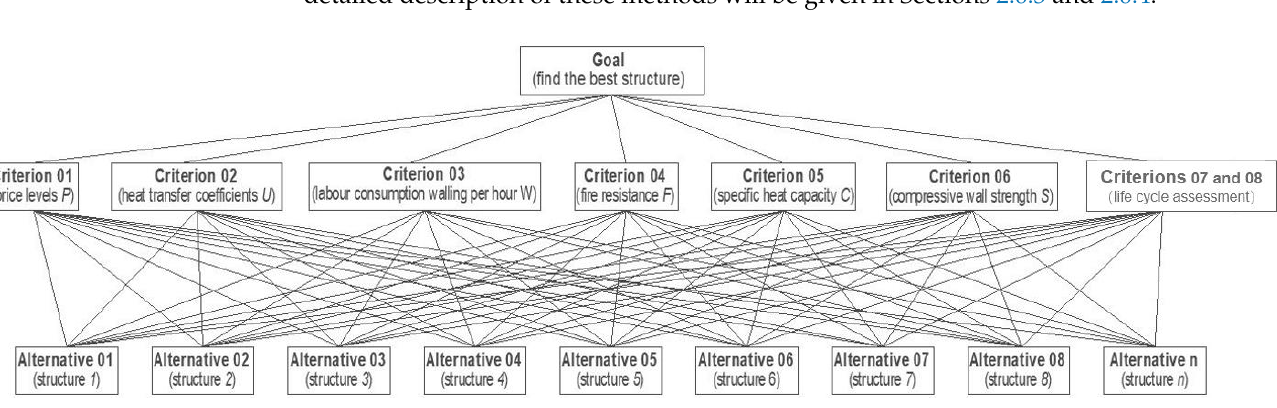
Figure 1. Example of a hierarchy of criteria.